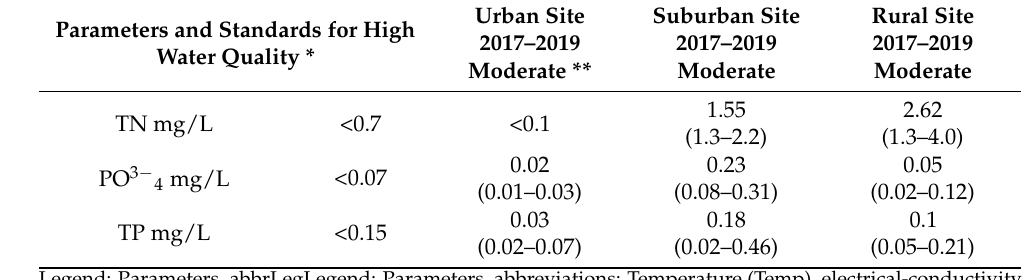
Table 1. Cont. Parameters and Standards for